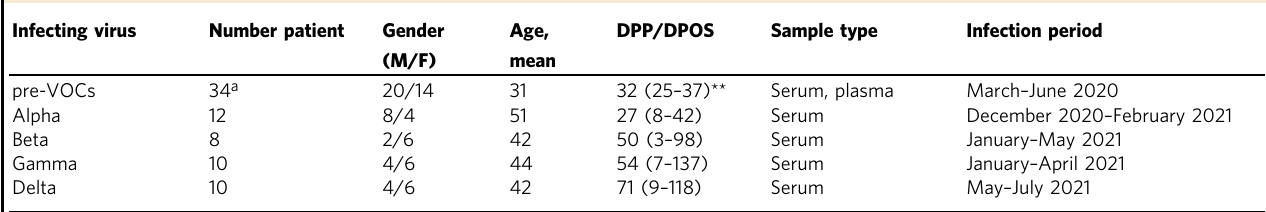
Table 1 Characteristic of convalescent individuals ’